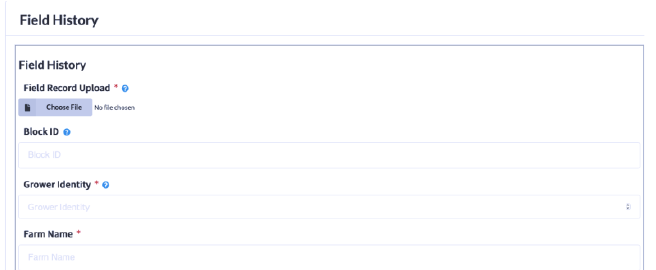
Figure 4: Webform viewable by the Farmer actor, requiring data upload into the DLT platform (see http://wallet.services).